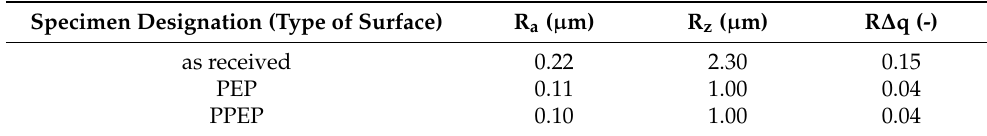
Table 4. Roughness parameter values of tested surface conditions: arithmetical mean deviation (R a ), the average maximum peak to valley height (R z ), the root mean square slope (R ∆ q).